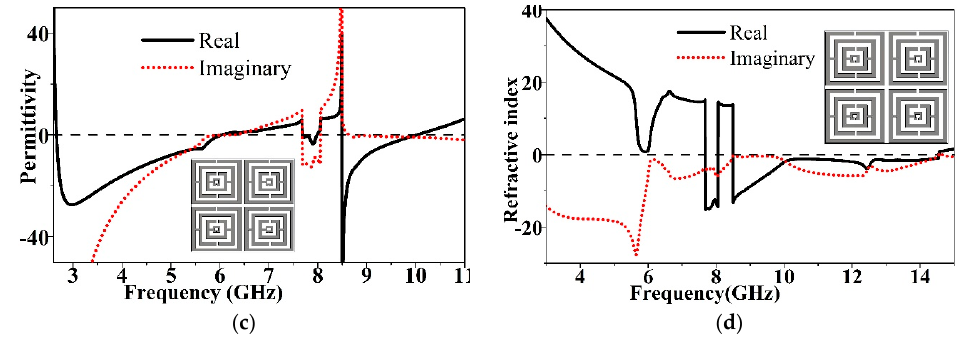
Figure 5. 2 × 2 array characteristics ( a ) Simulation setup ( b ) Permeability ( c ) Permittivity ( d ) Refractive index.